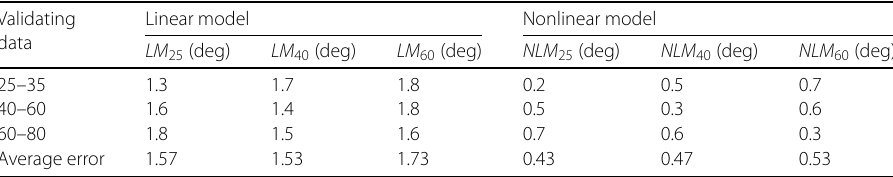
Table 1 Error comparison of the linear and nonlinear models without delay for the roll responses Validating data